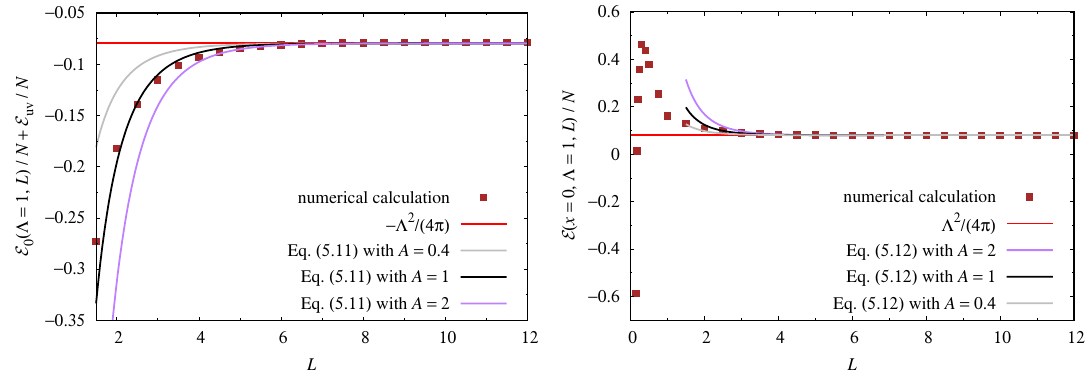
Figure 6 . The total energy density at the mid- point, E , is plotted against L for (cid:3) = 1 (cid:12)xed.